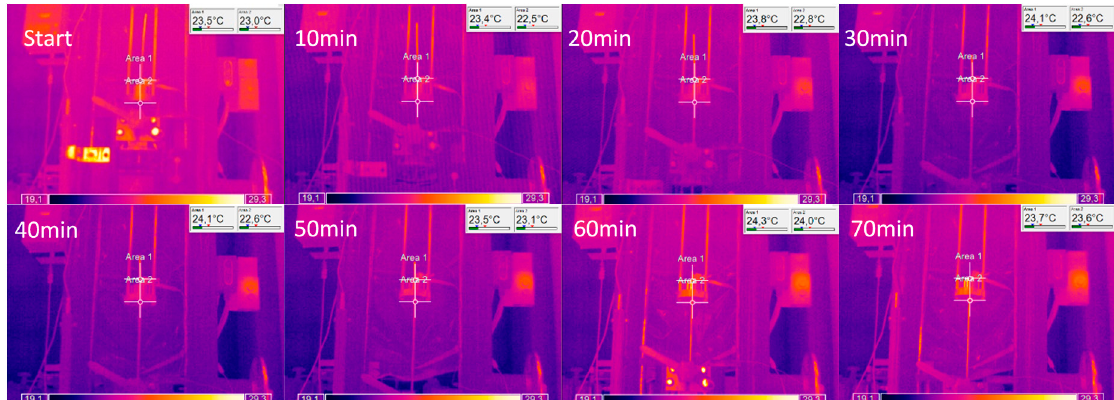
Figure 8. Recorded temperature changes during the analyzed wire drawing process (with the use of thermal imaging camera). The diameter of the die is 10 mm with a 2 α die angle of 16° and a bearing length of 1 mm and deformation coefficient of 1.3; material in its initial state is pre-hardened with a true strain of approximately 1.1 (according to Figure 3).